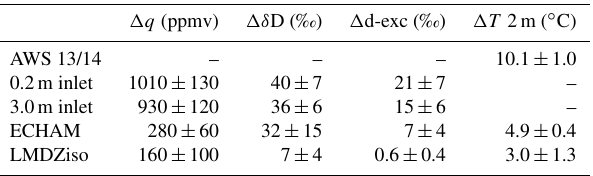
Table 4. Peak-to-peak amplitude of the 18 selected diurnal cycles. Uncertainties represent ± 1SD (average of the 24SD of the hourly mean values). ECHAM stands for ECHAM5-wiso.